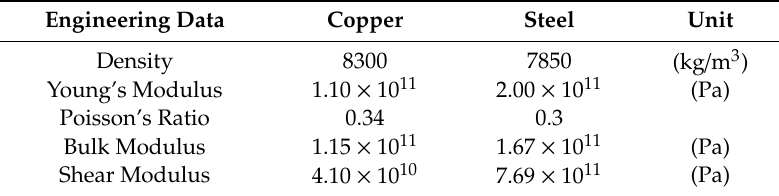
Table 1. Table of the material data used in the procured model.